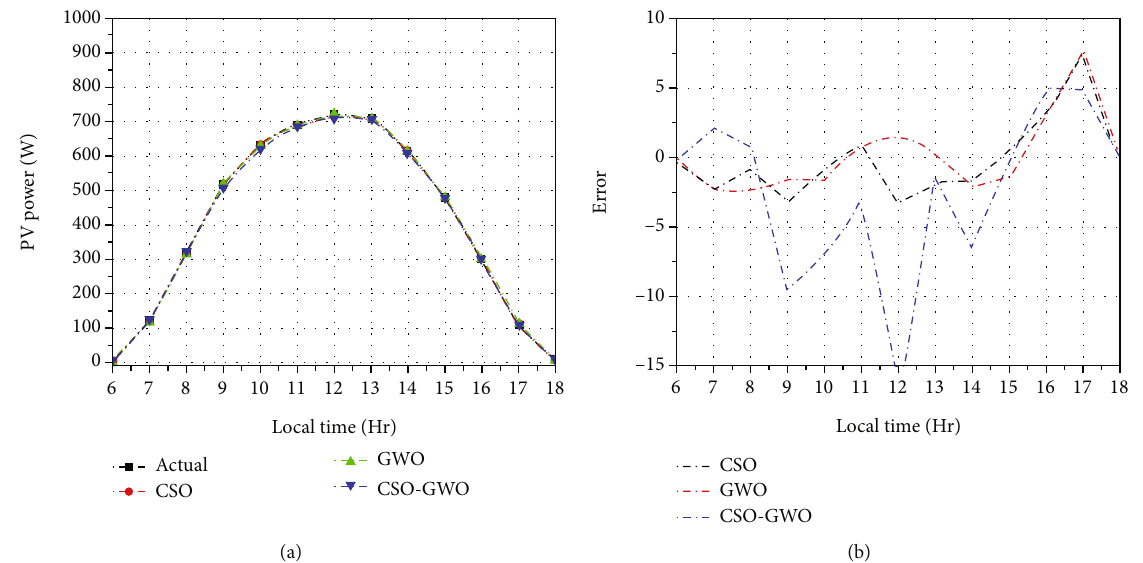
Figure 5: (a) hourly output power prediction of the PV system (b) error